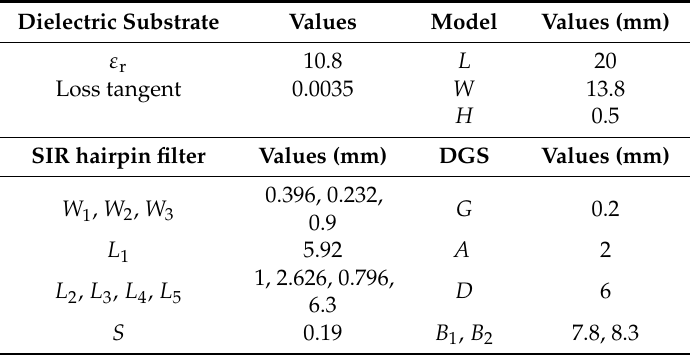
Figure 2. Frequency responses of return loss and insertion loss of the model of ( a ) one-DGS, ( b ) two-DGS and ( c ) three-DGS. Table 1. Filter specifications.